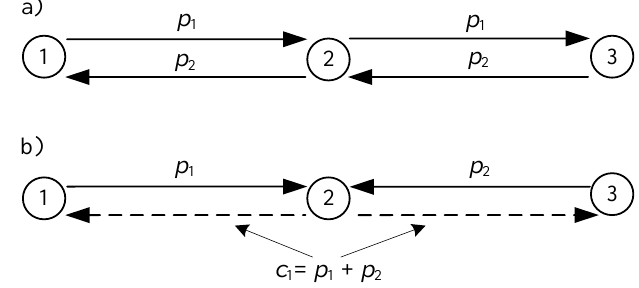
Figure 1. Example of information exchange without ( a ) and with inter-session network coding ( b ).